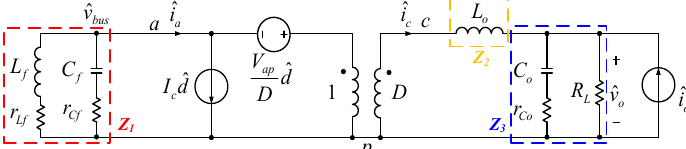
Figure 16. Small-signal model of the output impedance of an LC filter in series with a closed-loop Buck converter.